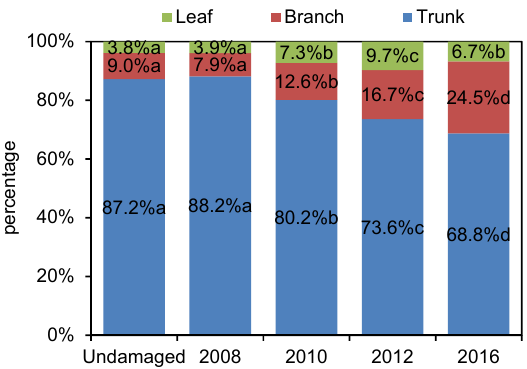
Figure 1. Distribution of biomass among different tree compartments (leaves, branches, trunks) at different recovery stages after the ice storm. The percentage within the section of each bar indicates the mean proportion value, while the different lowercase letters following the numbers indicate significant differences between the recovery stages tested by one-way ANOVA LSD.